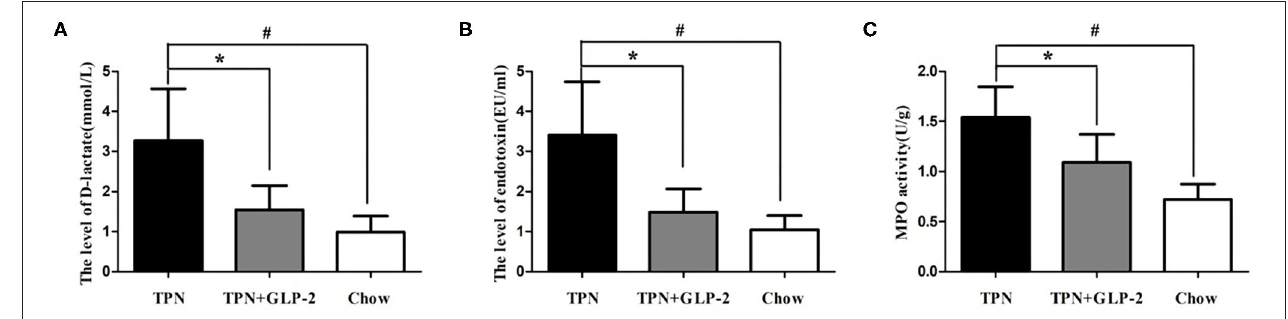
FIGURE 6 | The plasma D-lactate and plasma endotoxin levels and inflammatory infiltration of intestinal tissues. (A) The plasma D-lactate level. (B) The plasma endotoxin level. (C) The intestinal tissue myeloperoxidase (MPO) activity. Where *indicates p < 0.05 for TNP vs. TPN + GLP-2, and #indicates p < 0.05 for TNP vs.